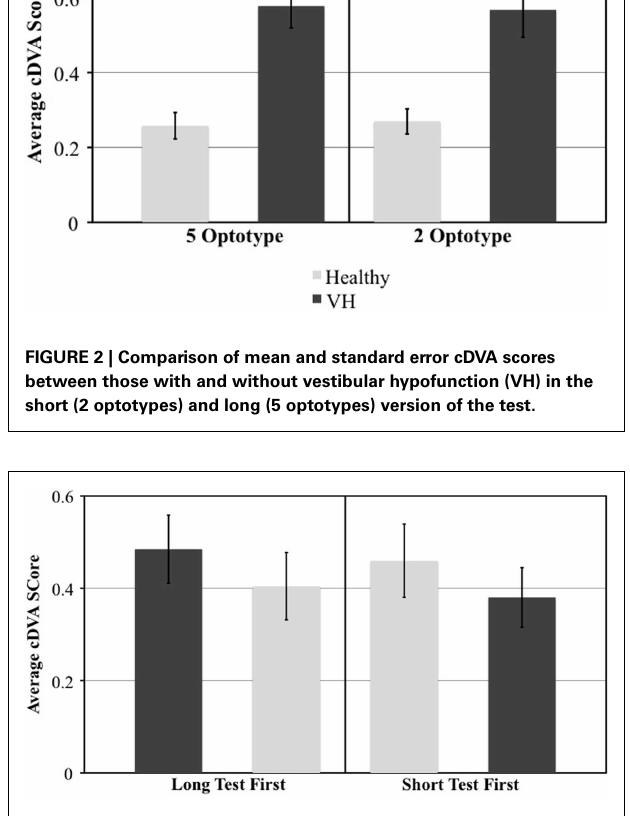
FIGURE 3 | Comparison of mean and standard error DVA scores based on test order.